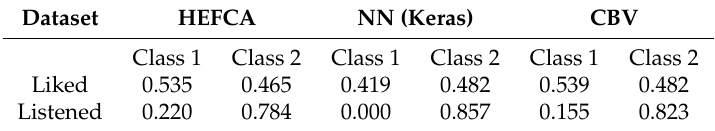
Table 8. F-measures of HEFCA, neural network and CBV on real-world problems.